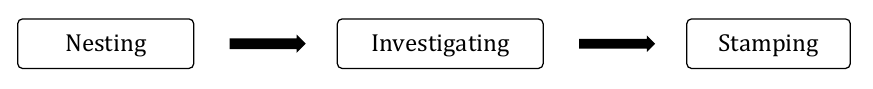
Figure 1: Visual Representation of the Appropriation Theory Nesting Investigating Source: Based on explanations by Caru and Cova (2006)